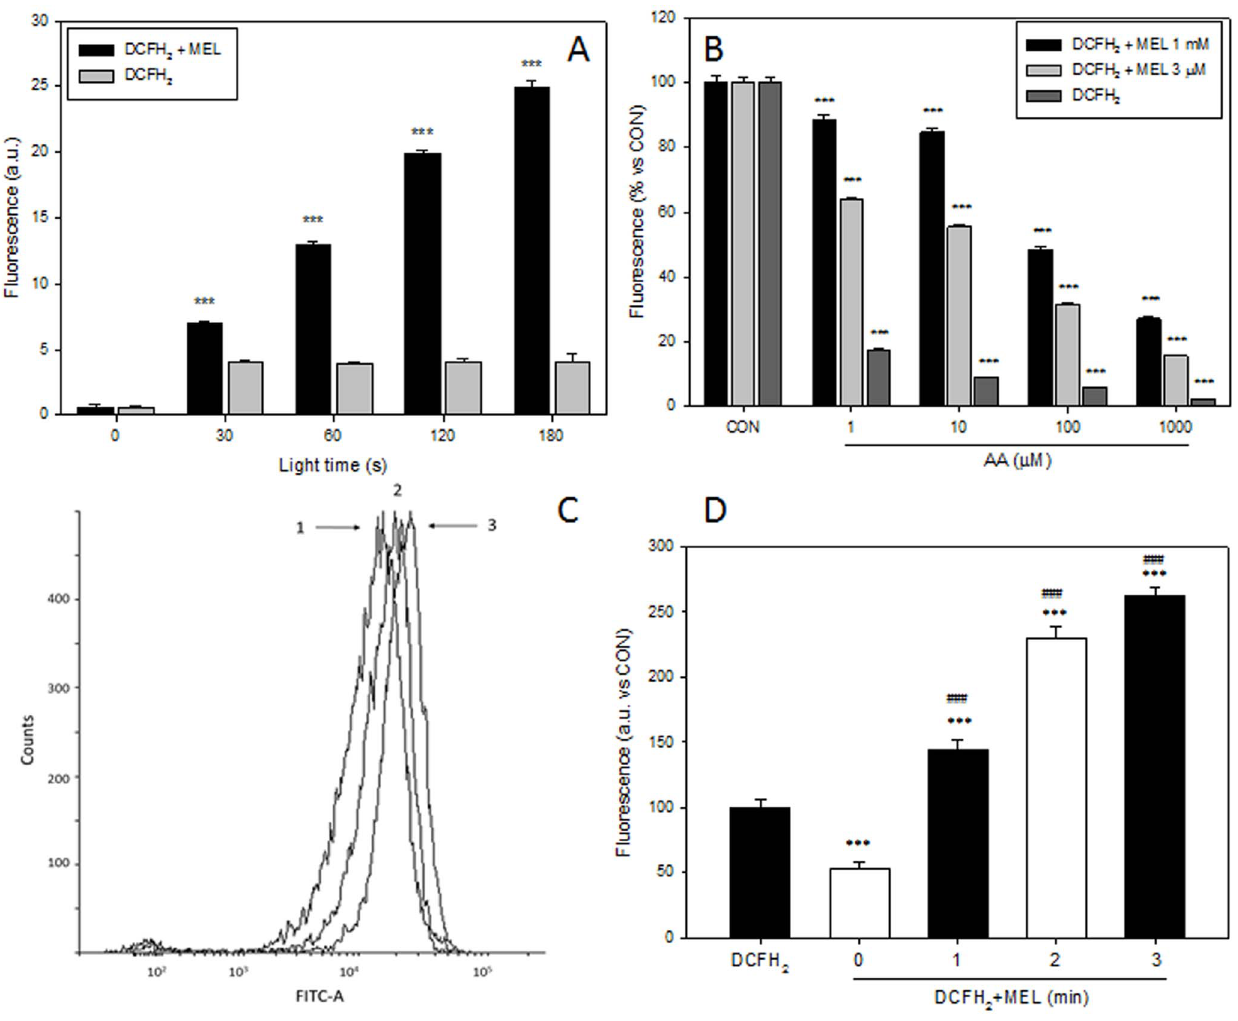
Figure 6. Dose dependence of DCFH 2 in melatonin enhancement of photooxidation invitro and in cellular models. A) Fluorescence of DCFH 2 (0.1 m M) alone or plus MEL (3 m M) under light. B) Fluorescence of DCFH 2 (0.1 m M) alone plus MEL (3 m M) or MEL (1 mM) in combination with AA (1–1000 m M) under light exposure for 60 seconds. C) Fluorescence, detected by flow cytometer, of HT22 cells incubated with 10 m M DCFH 2 alone (1) or with 1 mM MEL plus 10 m M DCFH 2 in darkness (2) or after 2 minutes of light exposure (3). D) Fluorescence, detected by microplate fluorimeter, of PC3 cells incubated with DCFH 2 (10 m M) alone or with 1 mM MEL plus DCFH 2 (10 m M) in darkness or after 1, 2 and 3 minutes of light